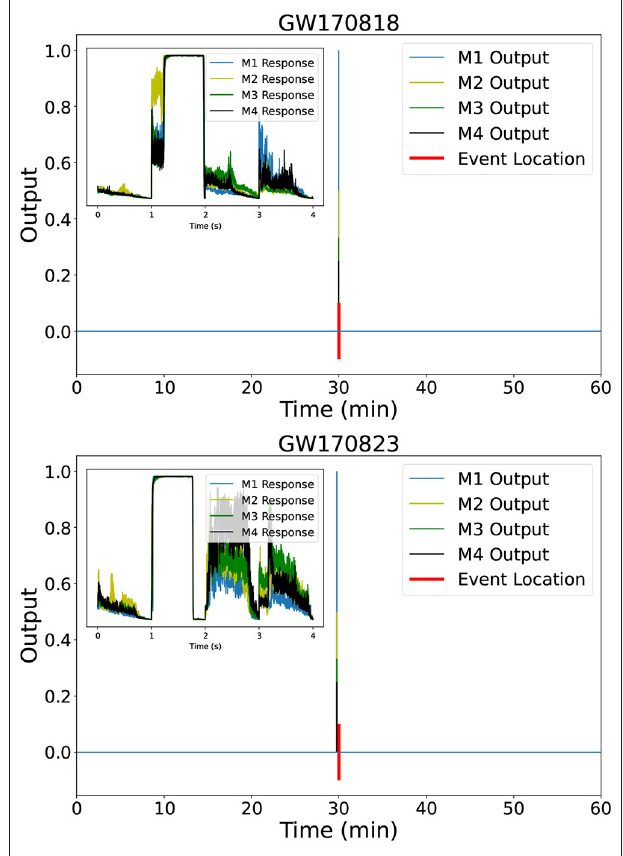
FIGURE 4 | Event detection. As Figure 3 , but now for GW170818 (top) and GW170823